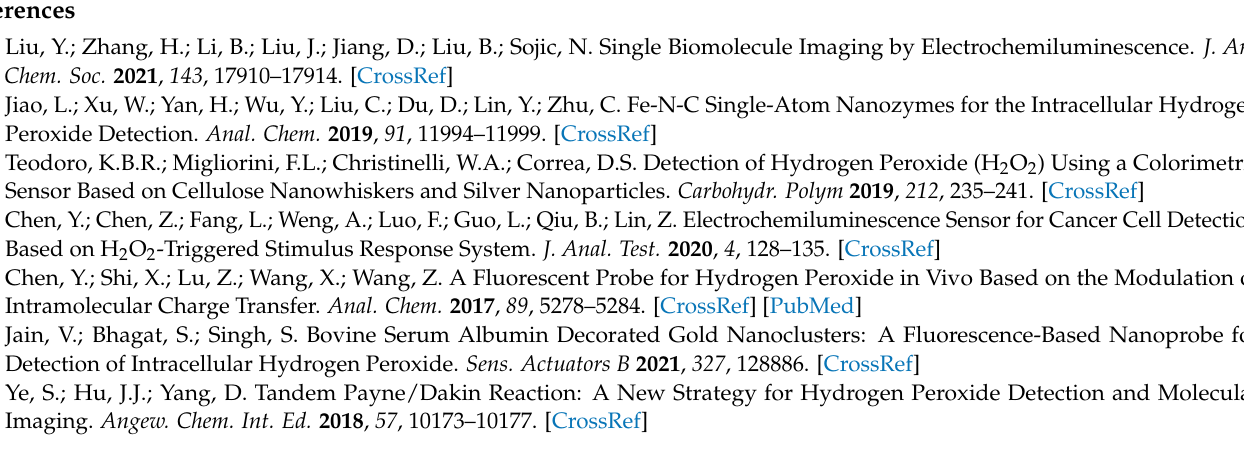
Figure S3: N2 adsorption-desorption isotherm curve of TAP-COF at 77 K; Figure S4: Exploring the impacts of this detection system, including (A) temperature, (B) pH, (C) TMB concentration, (D) COF concentration, and (E) H2O2 concentration; Figure S5: Steady-state kinetic analysis using the Michaelis-Menten model (A, B) and Lineweaver-Burk model (C, D) for TAP-COF. The concentration of H2O2 was 60 mM and TMB concentration was varied (A, C). The concentration of TMB was 0.80 mM and H2O2 concentration was varied (B, D); Table S1: Detection limit comparison of TAP-COF for H2O2 with some recently reported peroxidase mimics; Table S2: Comparison of analytical